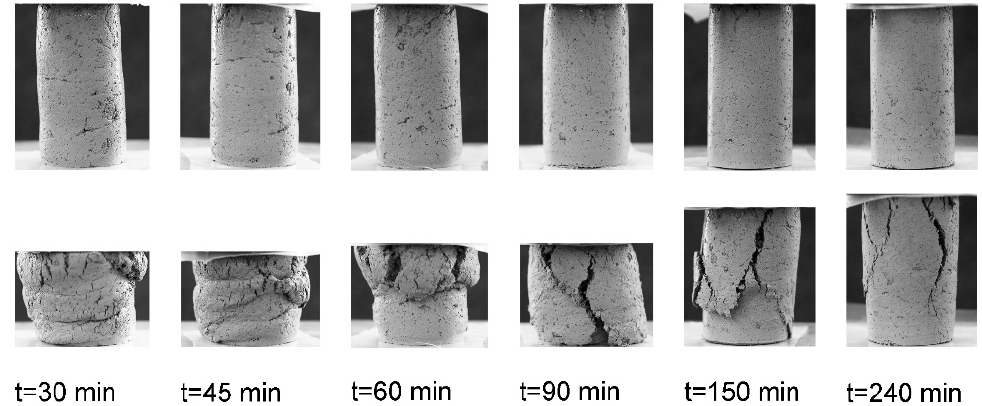
Figure 9. Mixture MIX-H samples in the green strength test. Photographs of demolded samples at di ff erent ages (first row); Photographs of damaged samples at di ff erent ages (second